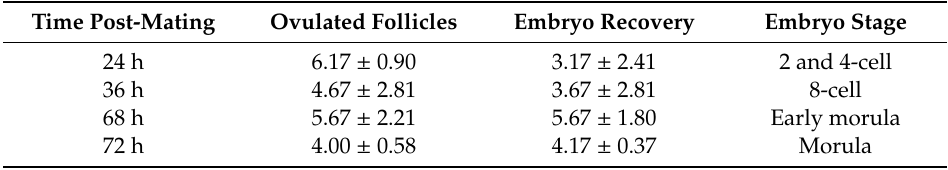
Data are presented as the mean ±